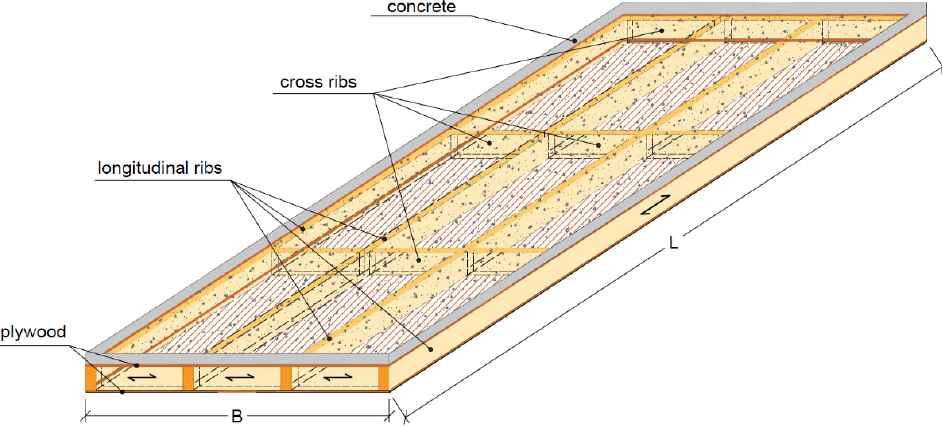
Figure 9. The view of timber–concrete composite with plywood rib panel with four longitudinal ribs and four rows of cross